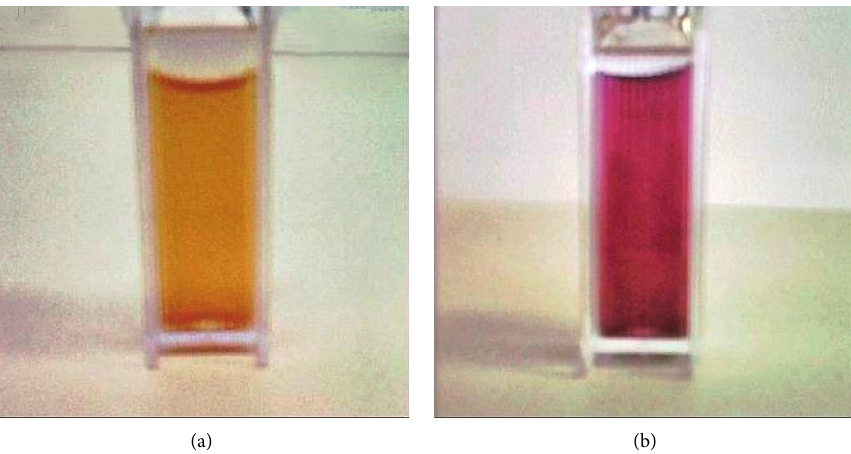
3 solution: (a) AgNO 3 solution